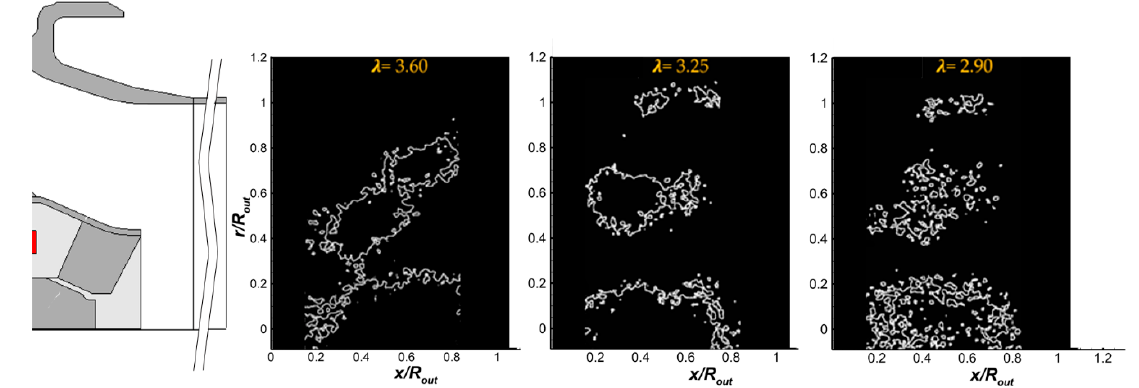
Figure 8. Typical instantaneous flame fronts for the three operating conditions (flow direction from left to right).